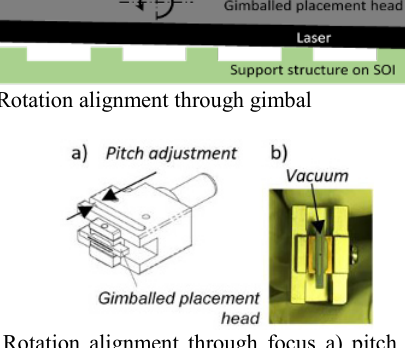
Fig. 4. Rotation alignment through focus a) pitch adjustment schematic, b) placement tool (FineTech GmbH & Co) with gimbal and pitch adjustment